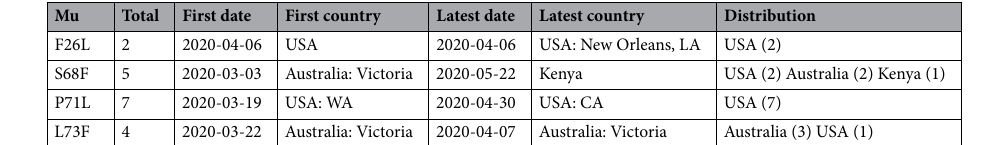
Table 13. Gene E—nonsynonymous mutations occurring in 2 or more sequences.